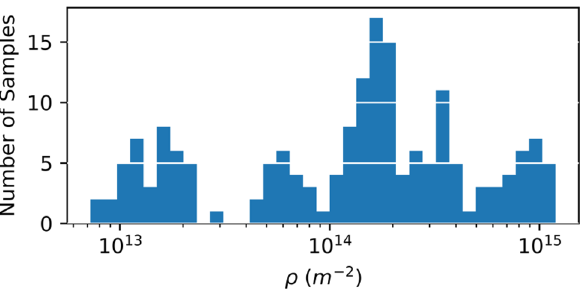
Figure 2. Histogram of dislocation densities in the database of Ta single crystal microstructures generated using DDD.